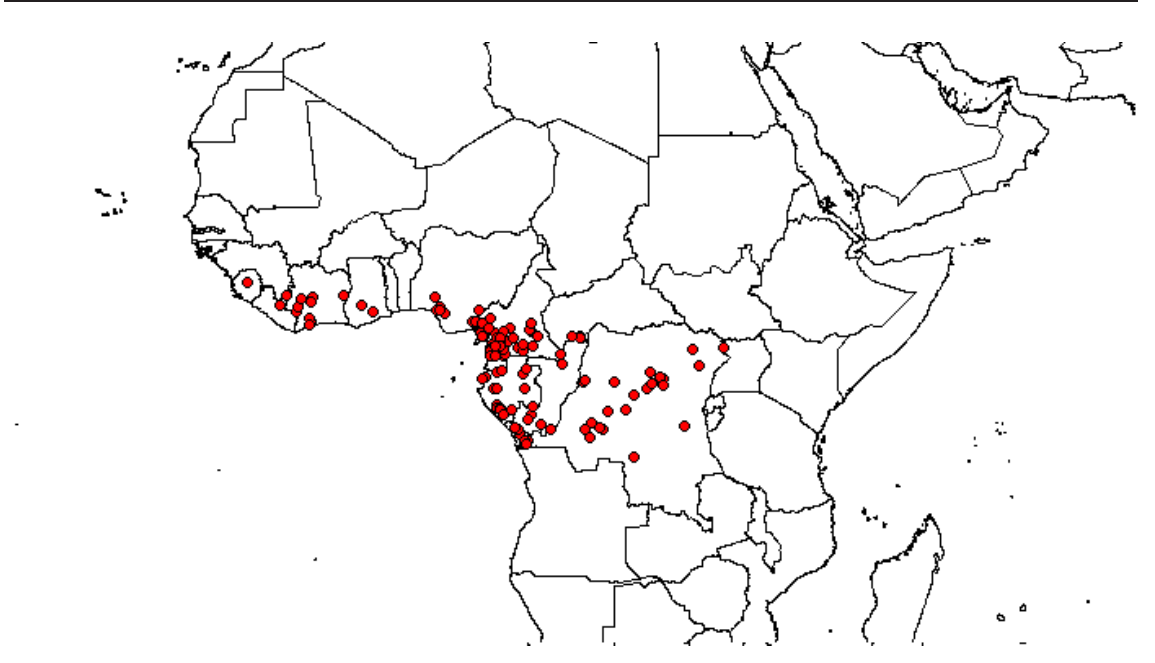
Fig. 9. Distribution map for Desplatsia subericarpa